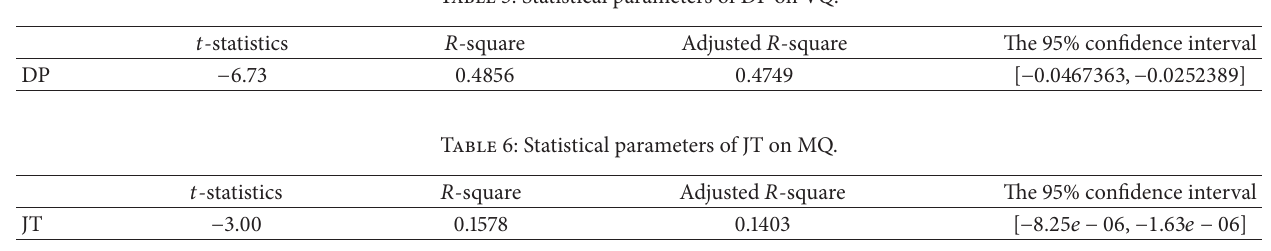
Table 5: Statistical parameters of DP on VQ.